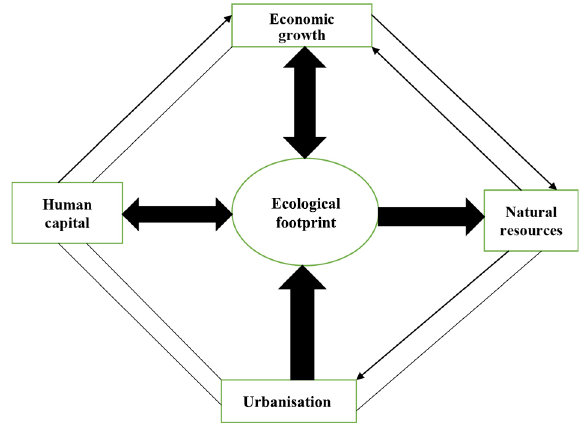
Fig. 2. Causality relationship schema.